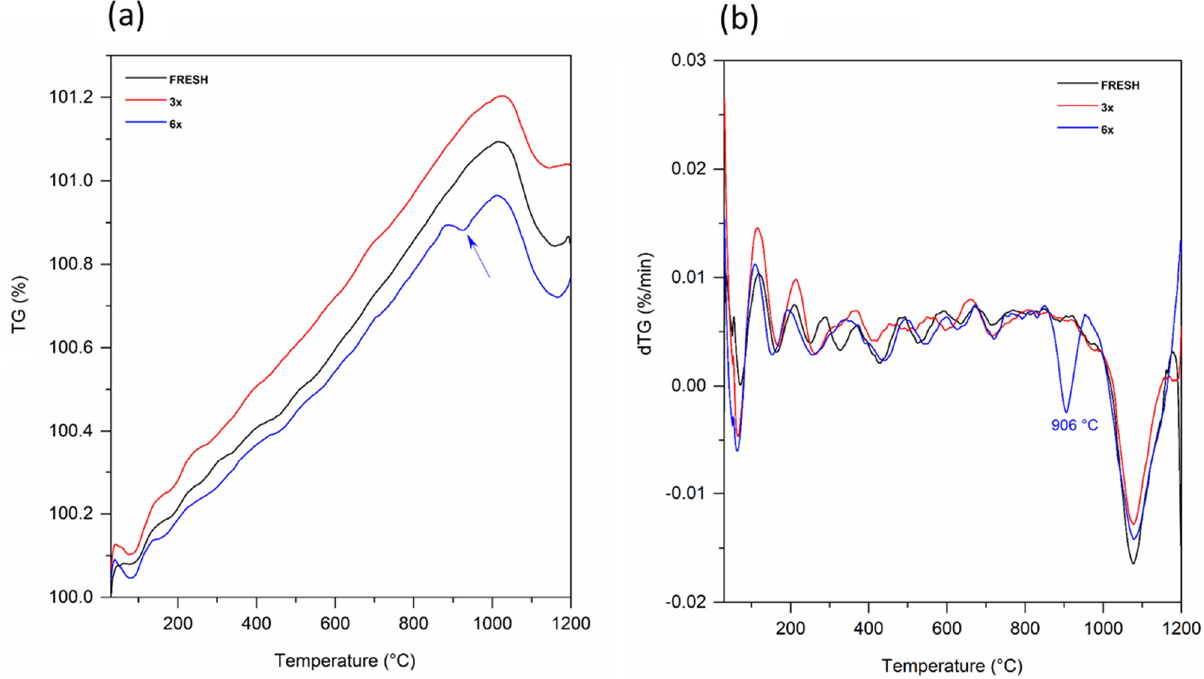
Figure 9. Thermal analysis of nontreated samples: ( a ) TG and ( b ) dTG curves. The significant temperature changes are marked.